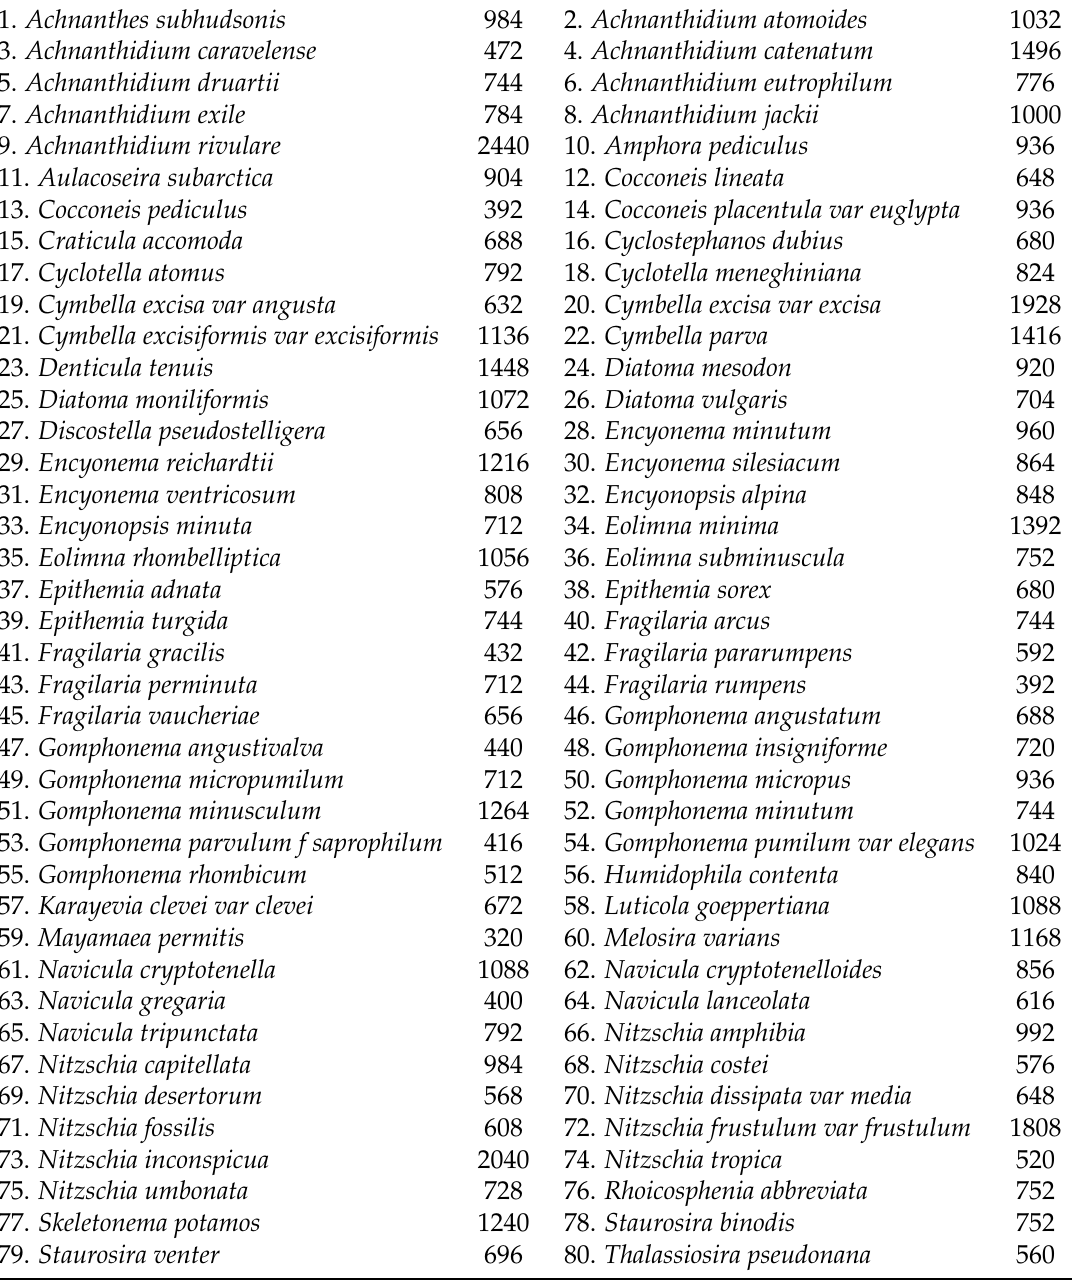
Table 2. Diatom species chart, showing the total number of samples per